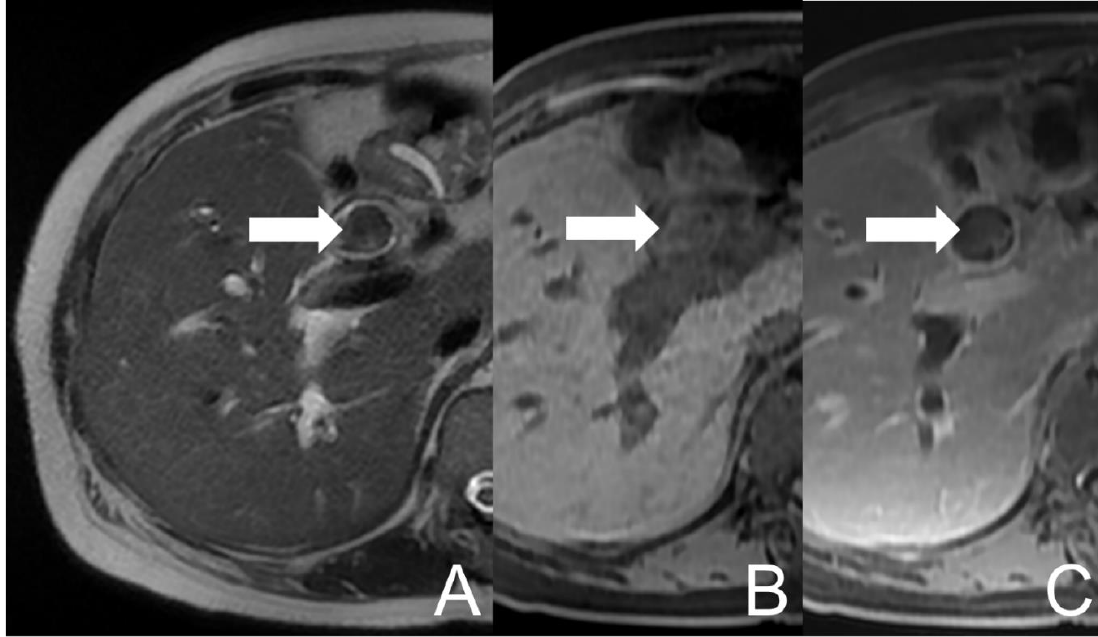
Figure 1. UCOGC of CHD and CBD in a 66-year-old female. The initial axial MRI images show a mass (arrow) with heterogeneous signal intensities in CBD, demonstrating relatively low signal intensity on the T2-weighted image ( A ) and relatively high signal intensity on the pre-contrast T1-weighted fat-saturated image ( B ), with faint enhancing foci on the post-contrast T1-weighted fat-saturated image ( C ). The imaging findings are suggestive of a neogrowth with hemorrhage.